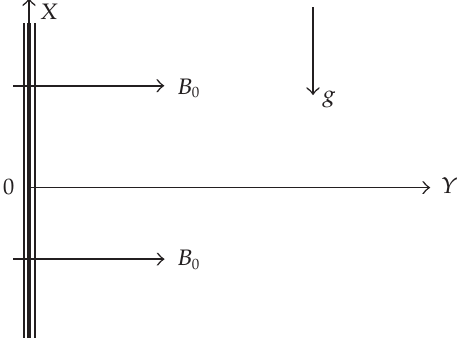
Figure 1.1 . Sketch of the physical